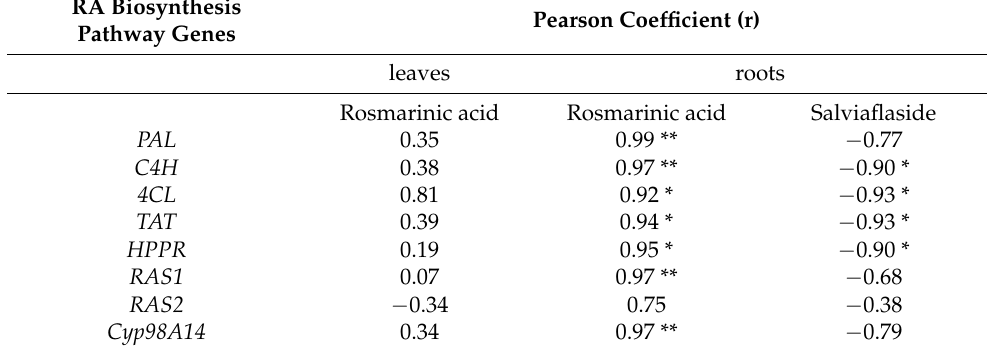
Table 4. Pearson’s correlation coefficient (r) analysis comparing the species-adjusted partial corre- lation between expression of rosmarinic acid biosynthesis pathway genes and rosmarinic acid and salviaflaside L content. * indicates a significant result at p < 0.05 and ** indicates a significant result at p <